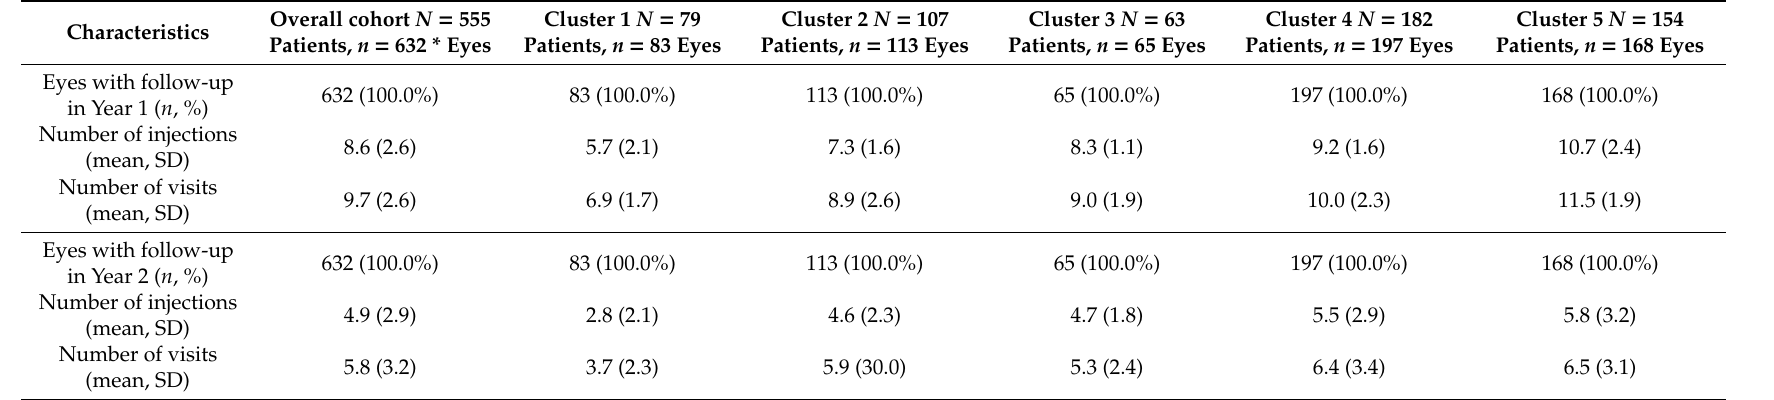
Table 5. Number of visits in the follow-up period for overall cohort and